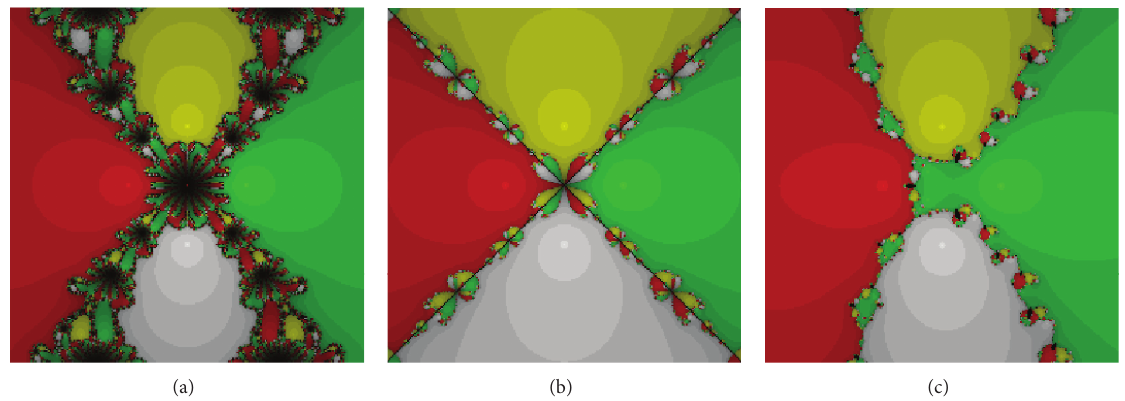
Figure 2: The basins of attraction for CM 2 4 (a), OM 4 (b), and MOM 4 (c) in problem 1.